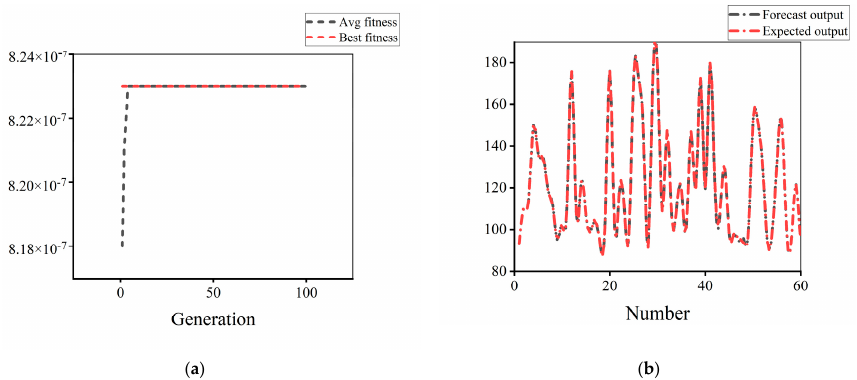
Figure 7. Neural network training graph: ( a ) Fitness variation diagram; ( b ) Test output error dia- gram.